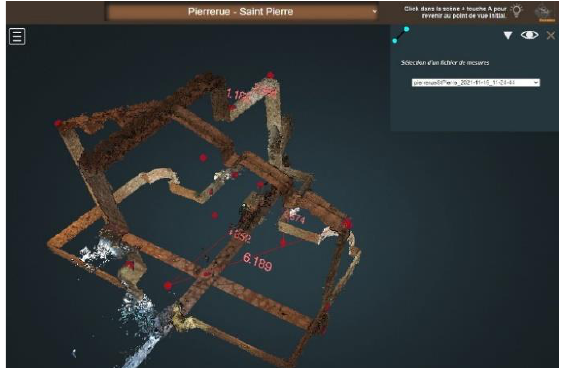
Figure 5 : Example of measurements made on the DXF data